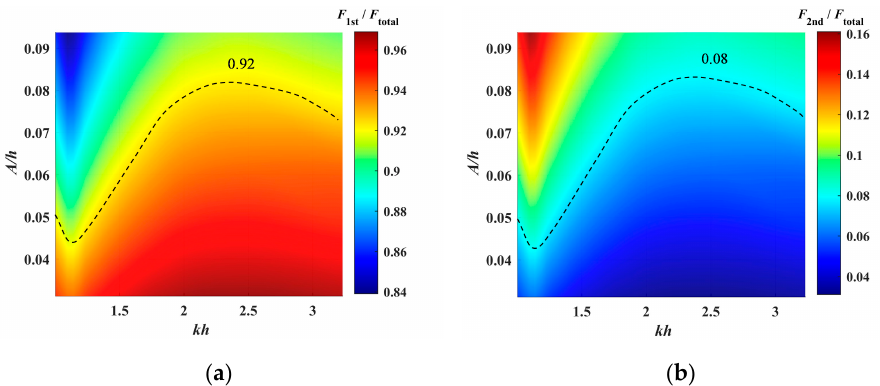
Figure 11. Variation of harmonics with the wave steepness kh : ( a ) linear force component; ( b ) second- harmonic forces.